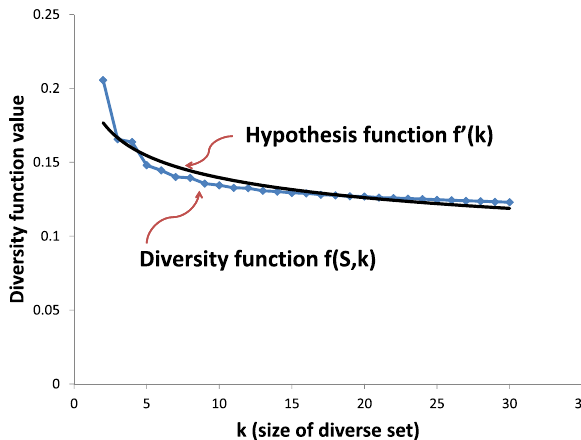
Fig. 3 Mapping of diversity function to hypothesis function using regression modelling